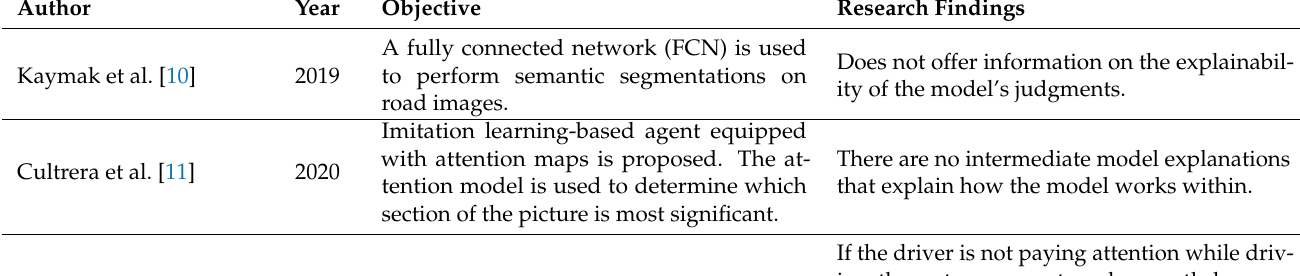
Table 1. Comparative analysis of various approaches for XAI-based autonomous